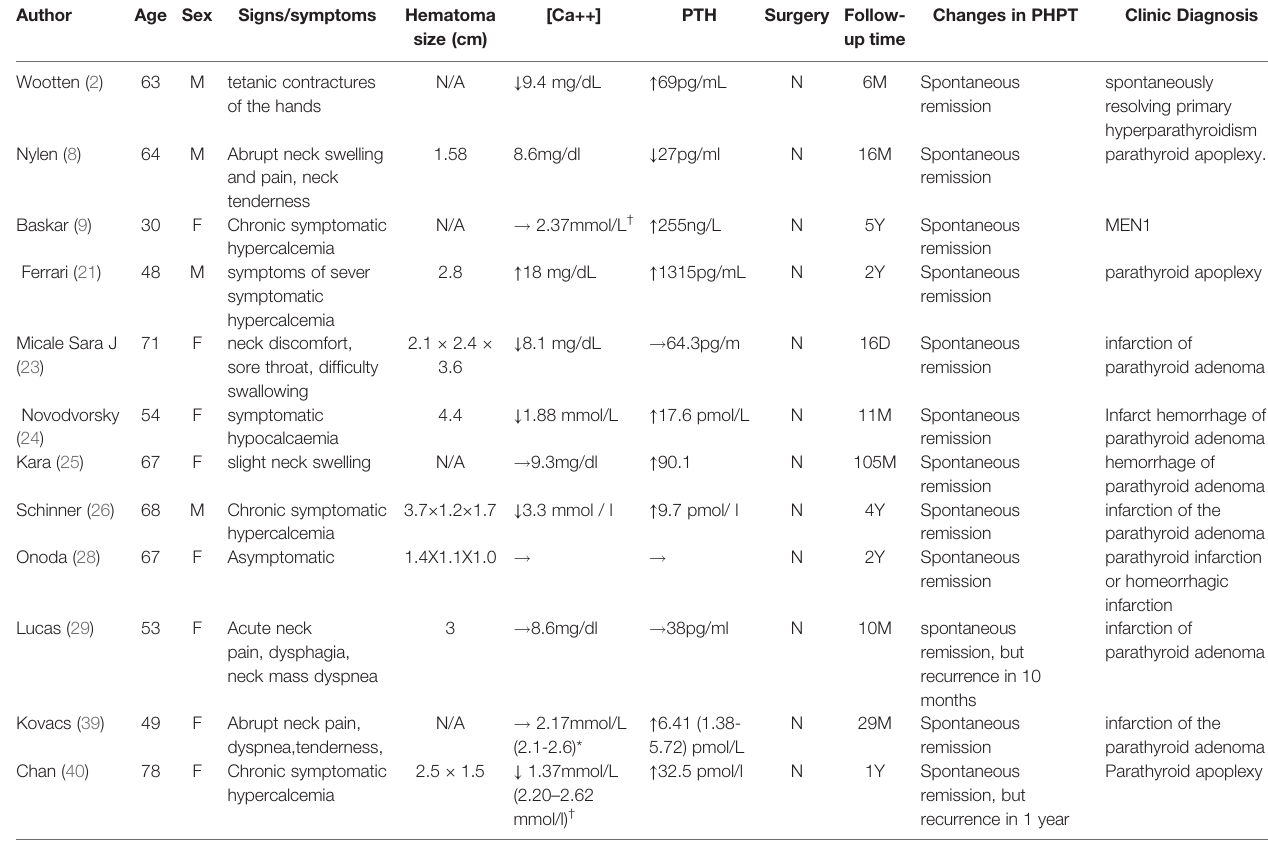
TABLE 1 | Case analysis of intracystic hemorrhage or necrosis of in situ primary parathyroid adenomas (Unoperated patients, n =